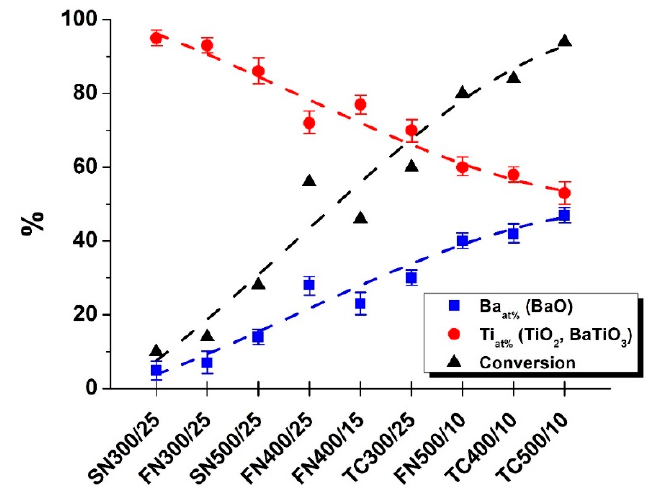
Figure 4. The atomic percentage (at % ) of Ba ( ■ ) and Ti ( ● ) based on EDS measurements, and the calculated conversions ( ▲ ) of the precursors. Dashed lines in the figure are guides for the eye.